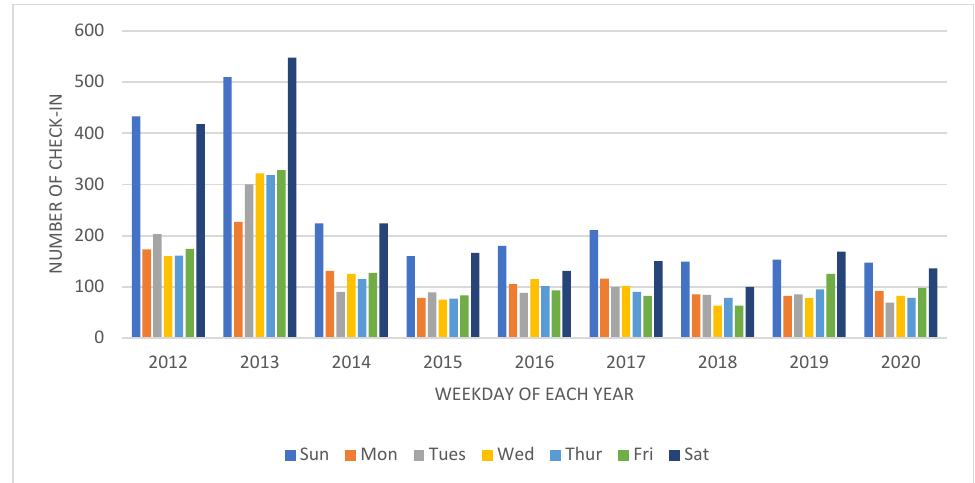
Figure 5. The weekly distribution of Fengjing Ancient Town Sina Weibo average daily check-in data during the 2012 to 2020 period (source: authors).